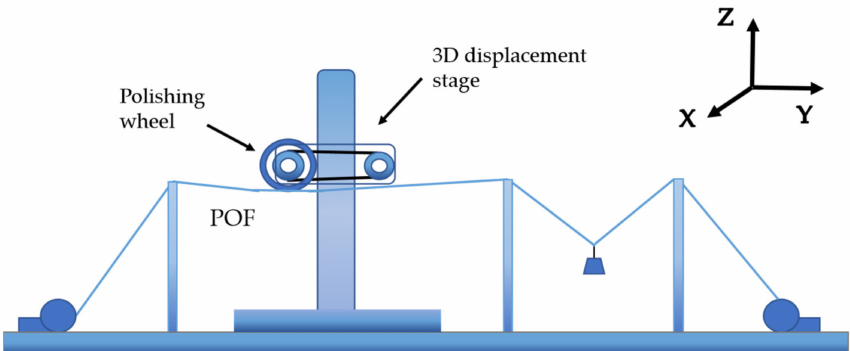
Figure 1. Schematic diagram of the optical-fiber-polishing